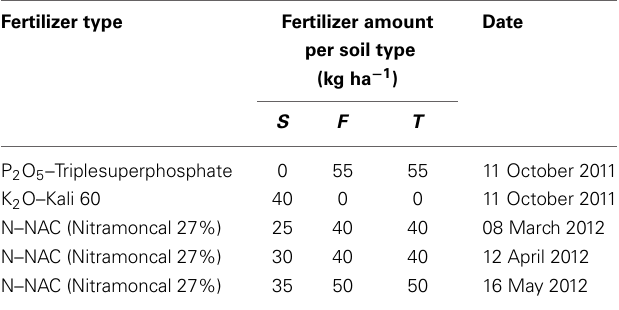
Table 1 | Fertilization of winter wheat crops in lysimeter plots with different soil types (S —calcaric phaeozem, F—gleyic phaeozem, T—calcic